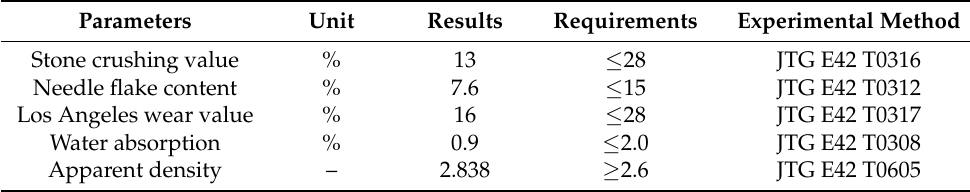
Table 3. Technical properties of coarse aggregate.